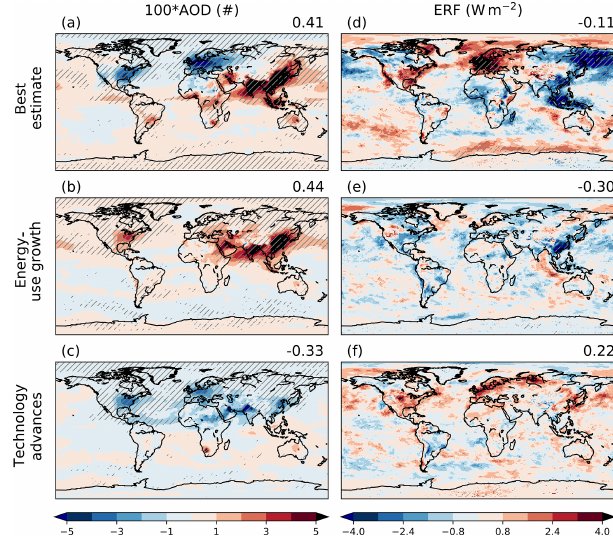
Figure 2. Changes in (a–c) 550nm aerosol optical depth multiplied by a factor of 100 (100 × AOD) and (d–f) the effective radiative forcing (ERF, Wm − 2 ) in response to 1970–2010 anthropogenic aerosol emissions changes. They are (a, d) the best estimate of total aerosol emission changes, (b, e) changes due to energy-use growth, and (c, f) changes due to advances in emission control technology. The numbers on the top right of each panel are the global means (NB again the AOD ones are multiplied by a factor of 100). The sta- tistical significance at the 5% level is calculated using the two-tailed Student’s t test, and these areas are denoted by the grey